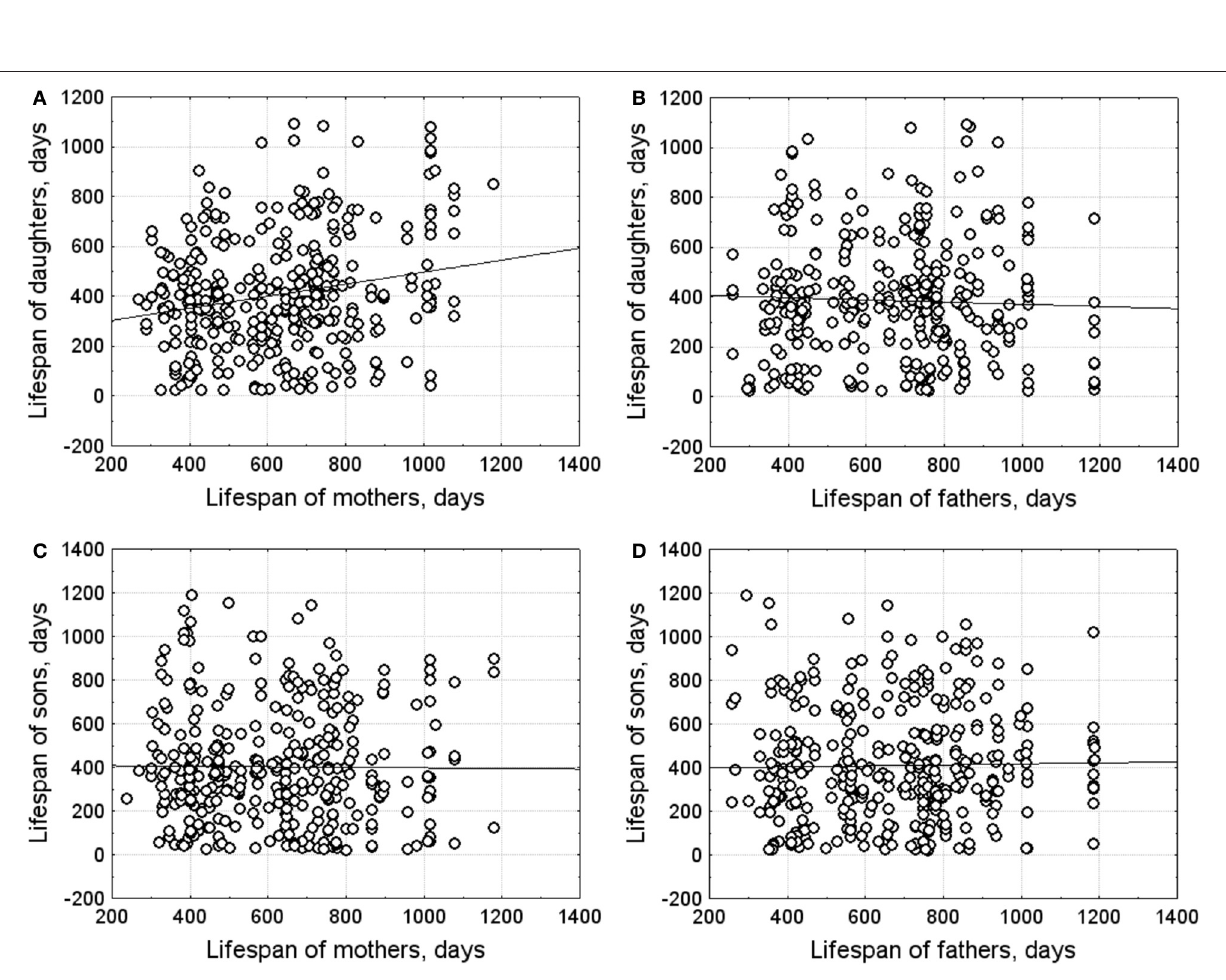
FIGURE 4 | Parent-offspring correlations of lifespan. (A) mother-daughter; (B) father-daughter; (C) mother-son; (D) father-son.